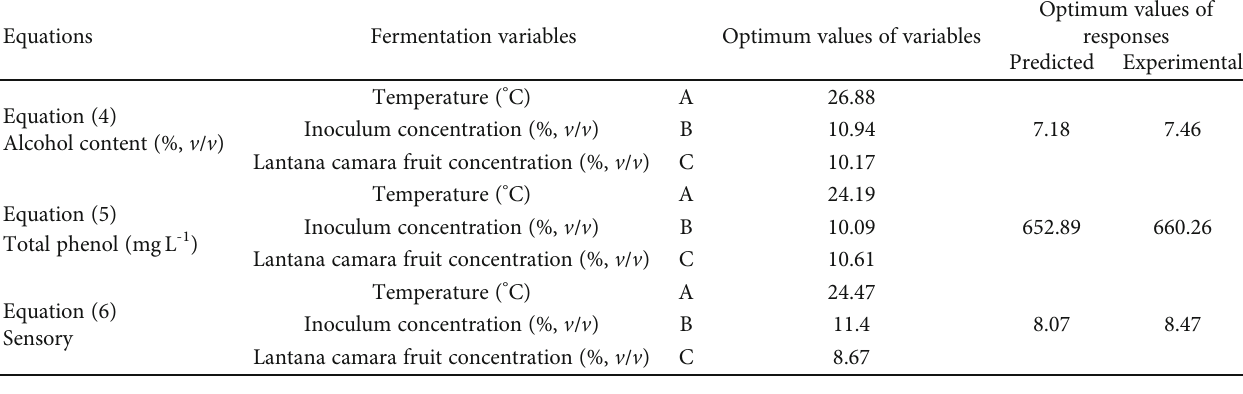
Table 7: Optimum values of fermentation variables and the predicted and experimental alcohol, total phenol content and sensory properties of the fermentation